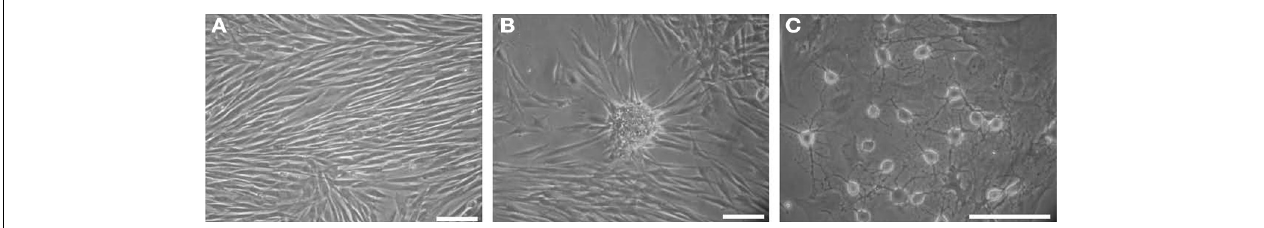
FIGURE 3 | Immunophenotypic characterization of populations with a fibroblastic morphology. (A) Flow cytometry histograms of specific markers expressed in the ADH-DPSCs of one